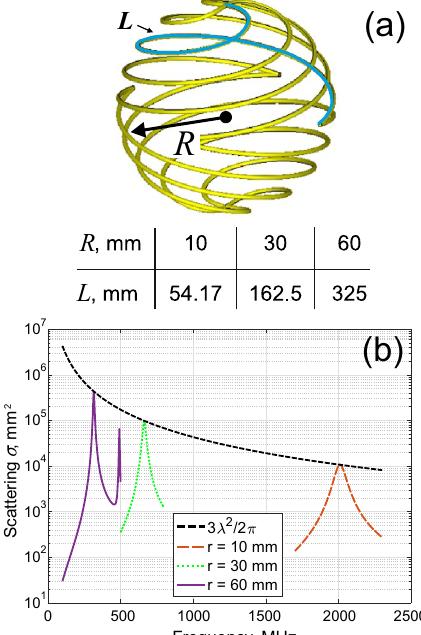
Figure 4. ( a ) Schematics of the 4-wire helical scatterer and the parameters used in the numerical modeling. ( b ) Total scattering cross-section as the function of frequency for three different structures (the parameters are in panel ( a ), the wires’ material is copper).